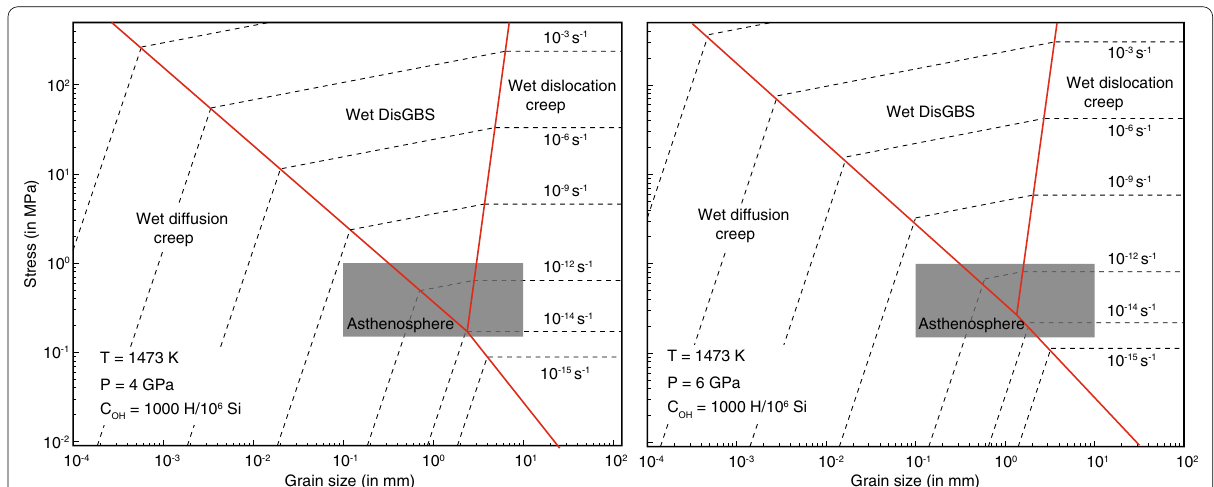
respectively. Figure S2. Strain time series for wet dunite from Chopra (1997) and the best fit model (red). Each strain time series was considered separately. Figure S3. Stress versus strain data and best-fitting predictions (red) for dry dunites (Chopra and Paterson 1984), where each curve is fitted separately. Table S1. Model parameters of wet dunites determined from the constant stress experimental data of Chopra (1997). Table S2. Flow law parameters of dry dunites determined from the constant strain rate experimental data. Each stress versus strain curve is fit individually. Table S3. Flow law parameters of dry San Carlos (SC) olivine aggregates. Steady-state parameters (n M and E M ) for the San Carlos olivine are from Karato et. al. (1986). The best-fitting values for dry dunites are given for comparison. Table S4. Flow law parameters of wet San Carlos (SC) olivine aggregates. Only A K and A M are given and the other parameters are the same as in Table 5. The values for dunite are given for comparison. The San Carlos olivine best-fitting values are within the uncertainties of our wet dunites estimation.